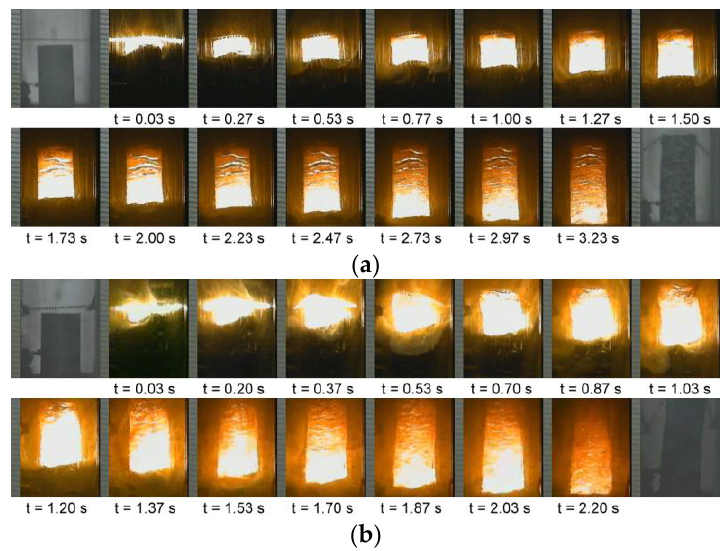
Figure 2. Time sequences of recorded SHS images illustrating self-sustaining combustion wave of ( a ) Equation (1) and ( b ) Equation (3).